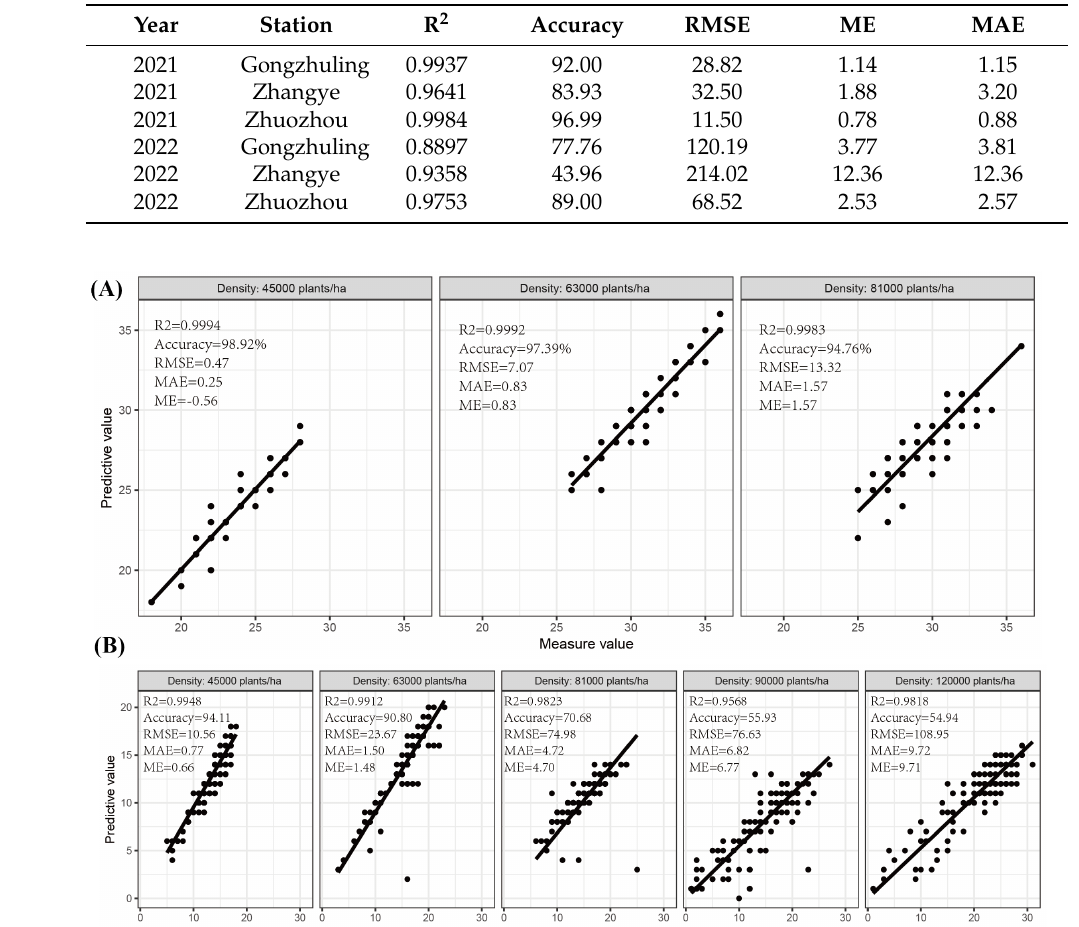
Table 3. Performance of the seedling measurement system in predicting maize seedling count.